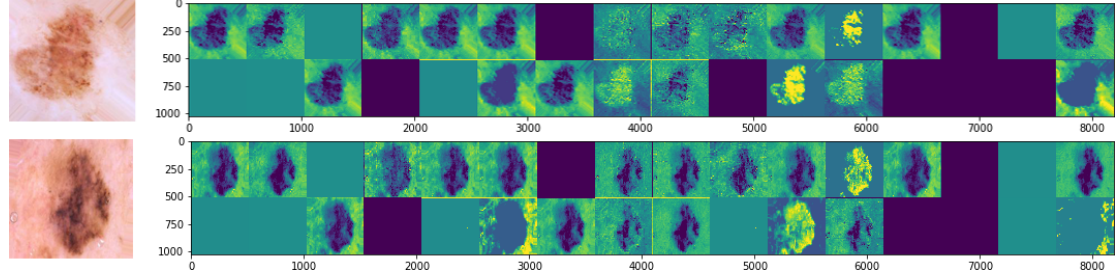
Figure 5. Artificially generated images of most swear type of skin cancer, melanoma by GANS. The top left, right, and bottom blocks of images represent the melanoma images generated by GAN, DeLiGAN, and TED-GAN (proposed), re- spectively. By having a close look at upper two blocks of images, we can observe the repetition of generated images. The green, blue, and yellow blocks contain similar images. Diversity in the images can clearly be observed visually in the proposed block (bottom one).